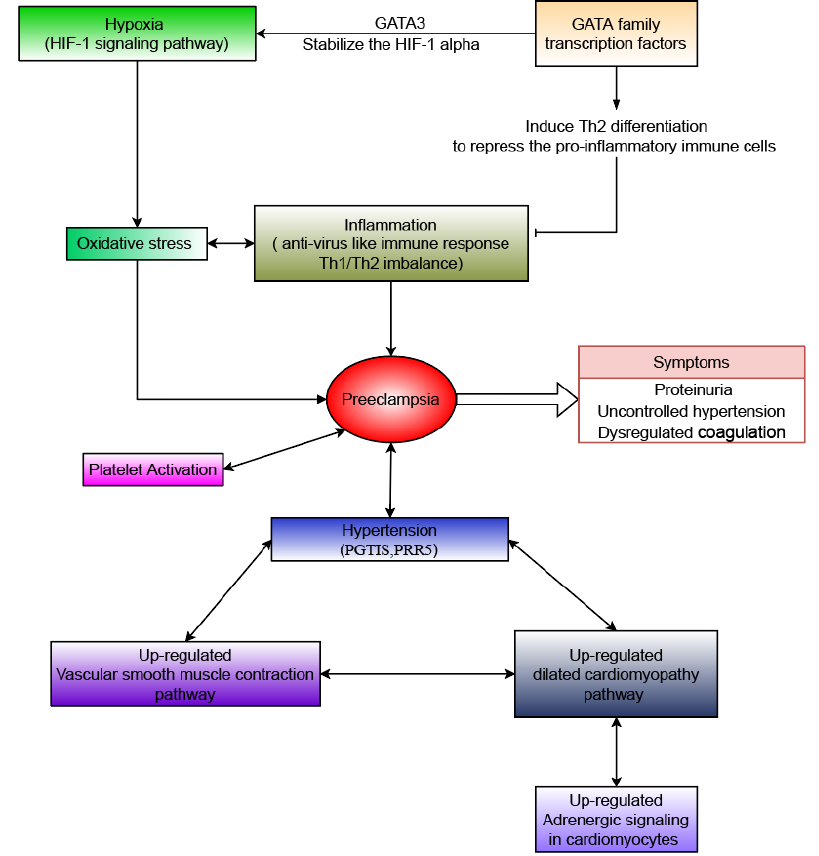
Figure 5. The mechanism map.